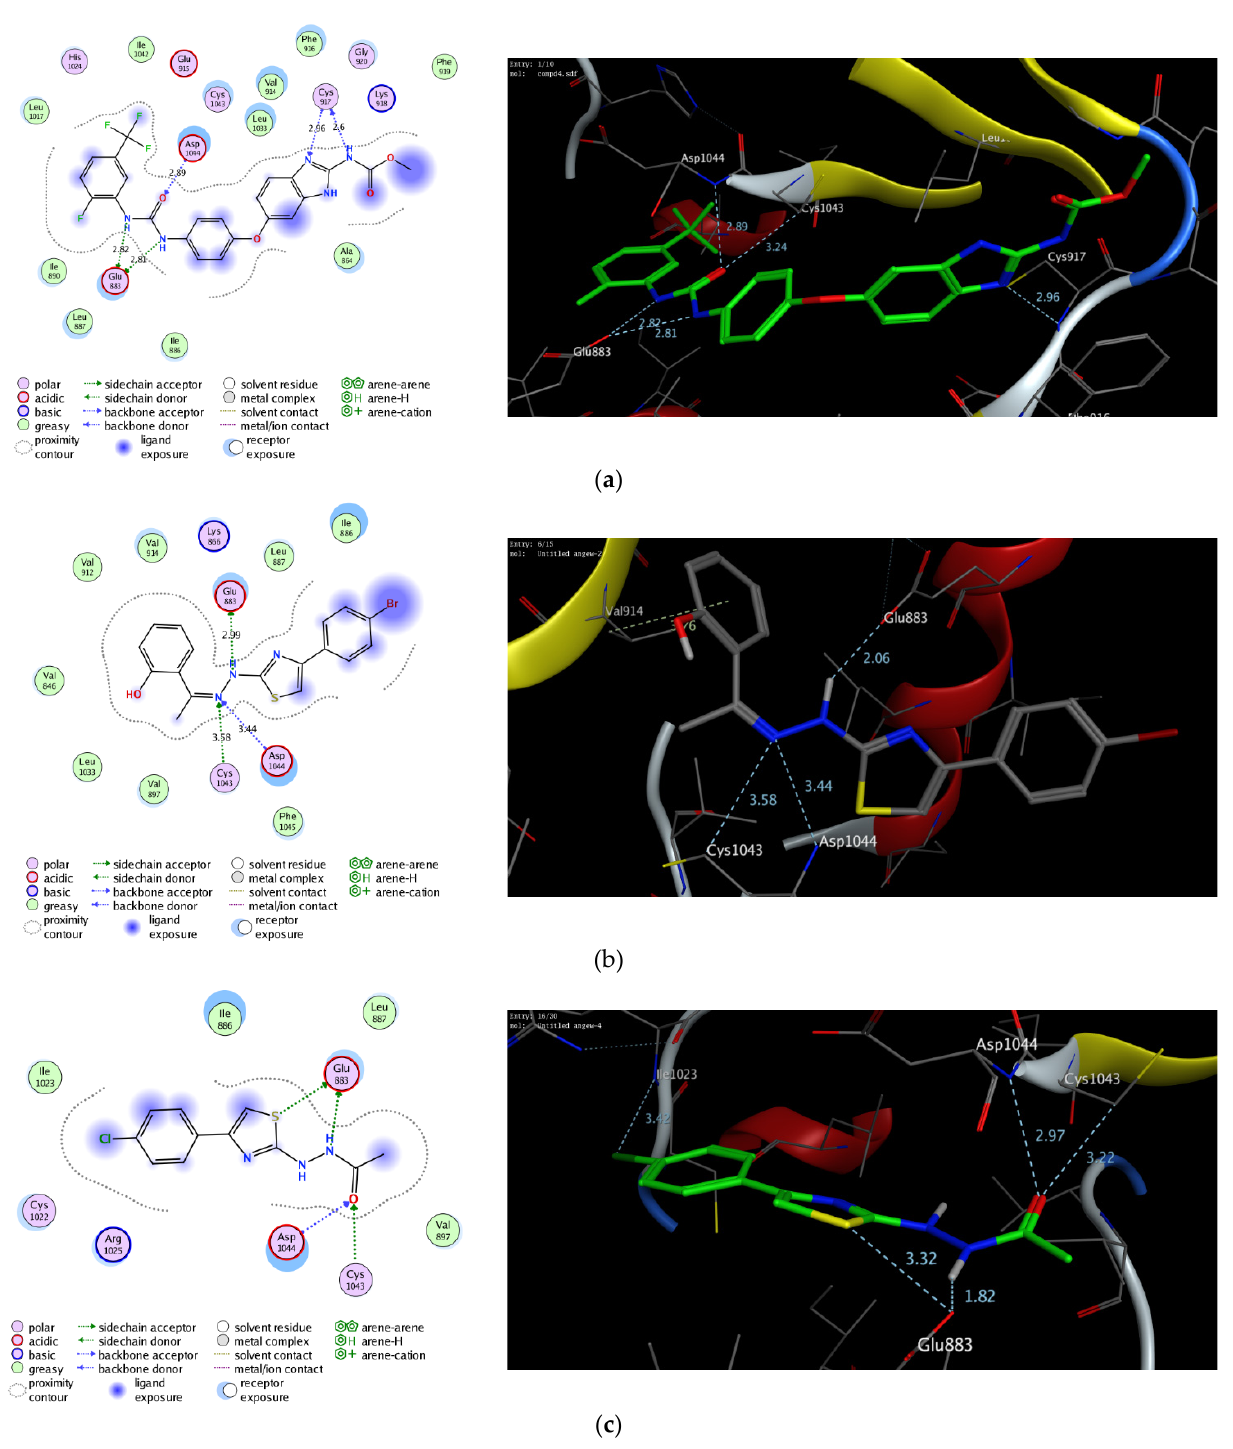
Figure 7. The 2D and 3D molecular docking interactions of the benzimidazole-urea ligand ( a ), compound 3c ( b ), and compound 4 ( c ) into the binding pocket of VEGFR2 (PDB code: 2oh4 ) protein.